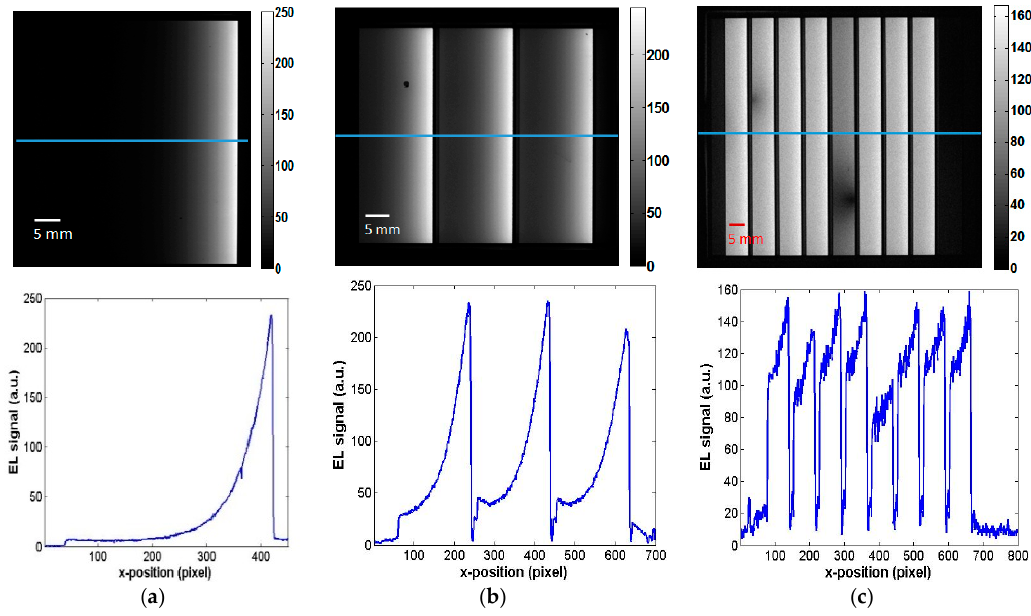
Figure 7. EL images and corresponding line scan of EL signal along the middle of: ( a ) TF-1; ( b ) TF-3; and ( c ) TF-9 modules.